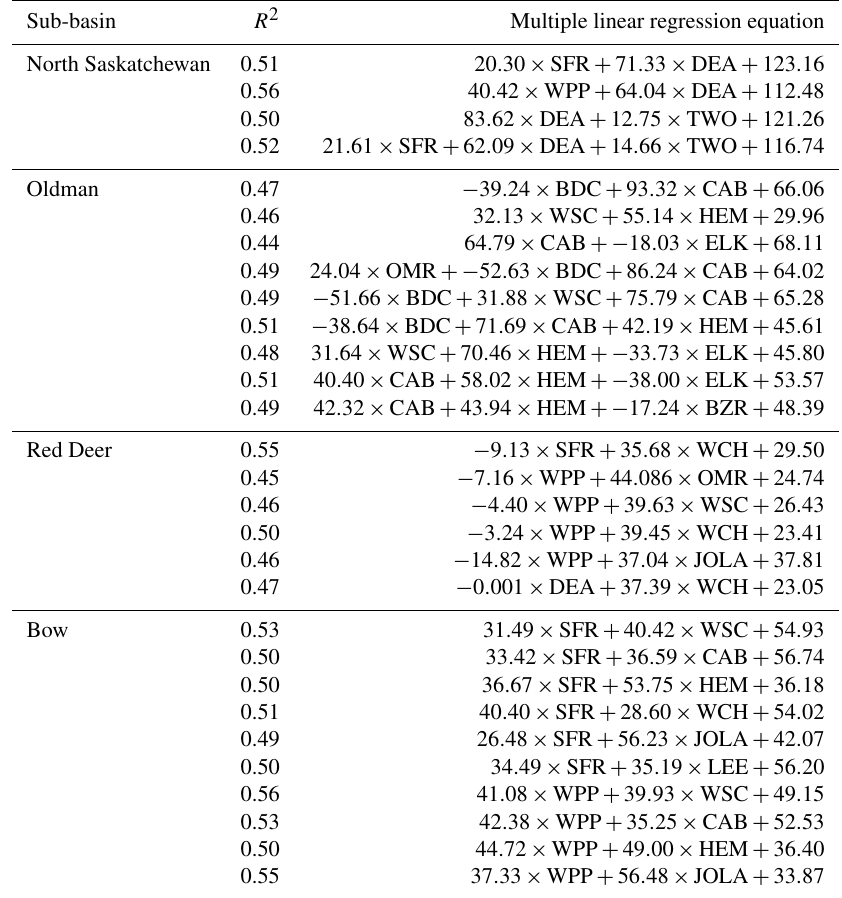
Table 1. Regression equations and R 2 values obtained in 2-year (biennial) flow reconstructions using tree-ring chronologies for